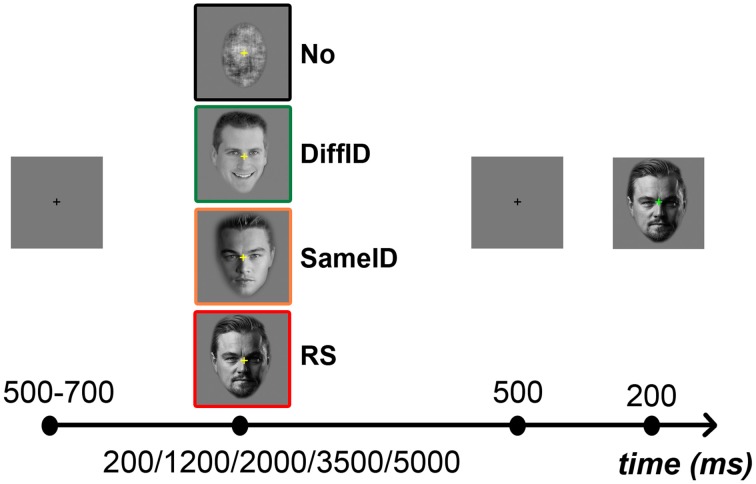
Experimental protocol and illustration of the different types of adaptors. In the beginning of each trial a fixation cross was presented in the center of the screen for a short interval ranging randomly between 500 and 700 ms, followed by one of the four adaptors (from top to bottom: No, signaled by a black frame; DiffID, signaled by green; SameID, signaled by orange; and RS, signaled by red) which was visible for either 200, 1200, 2000, 3500, or 5000 ms. This was followed by the presentation of a blank screen for 500 ms, and then the test face was displayed for 200 ms.